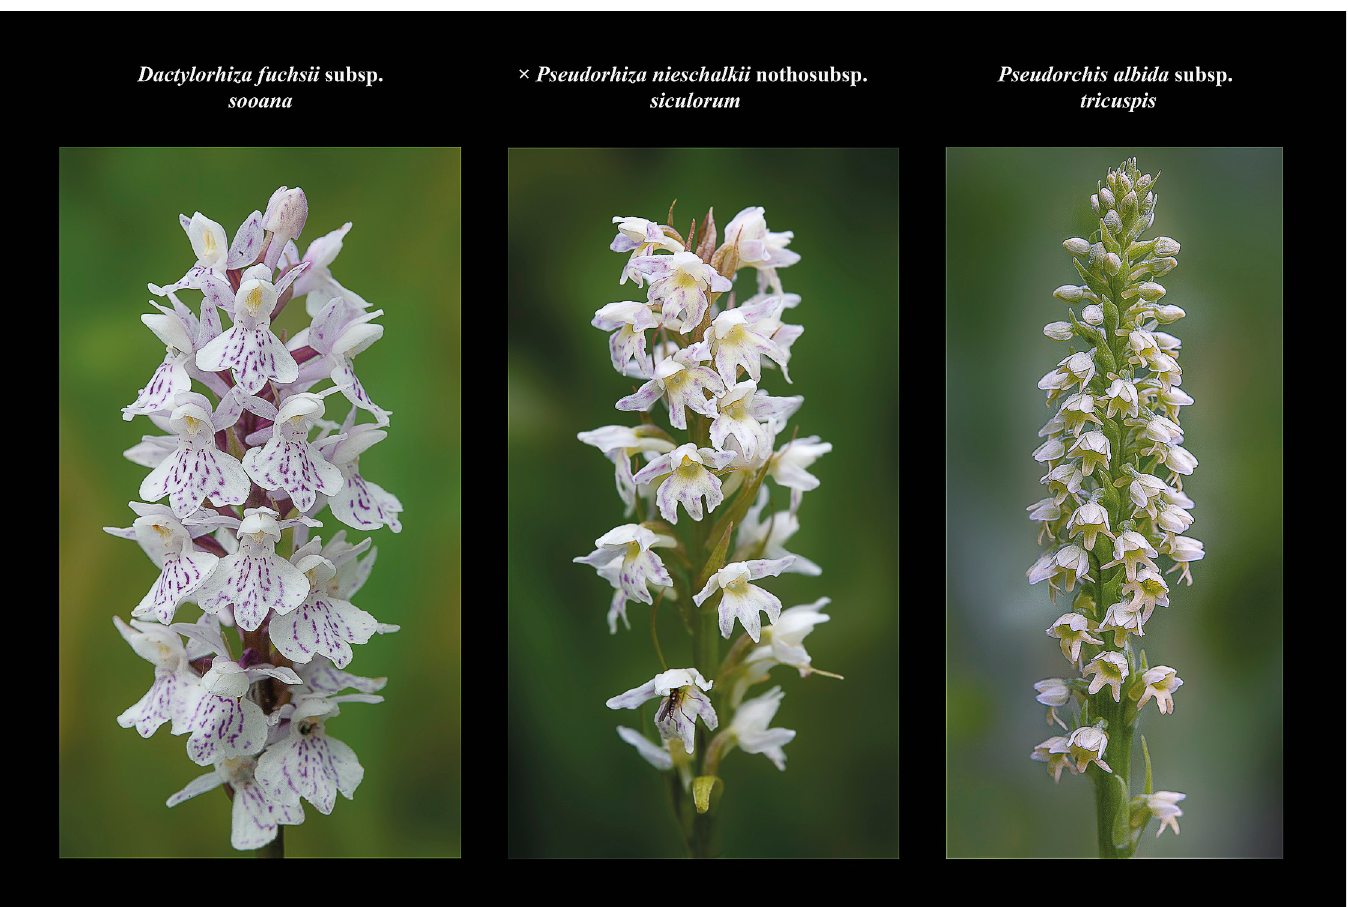
Fig 10. Morphological comparisons of × Pseudorhiza nieschalkii nothosubsp. siculorum and parents. The following three comparison diagrams show the intermediate characters of the hybrid’s habitus (Fig 9), inflorescence (Fig 10) and flowers (Fig 11), compared to those of its parents. The hybrids are almost as tall as the parents. The hybrid’s inflorescence is less floriferous and flat topped, resembling more that of D . fuchsii subsp. sooana parent. The flowers’ labellum is deeply three-lobed, very similar